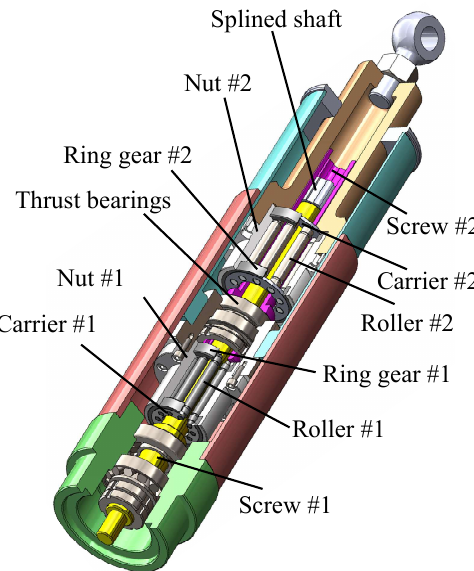
Figure 3. Structure of the two-stage planetary roller screw mechanism.